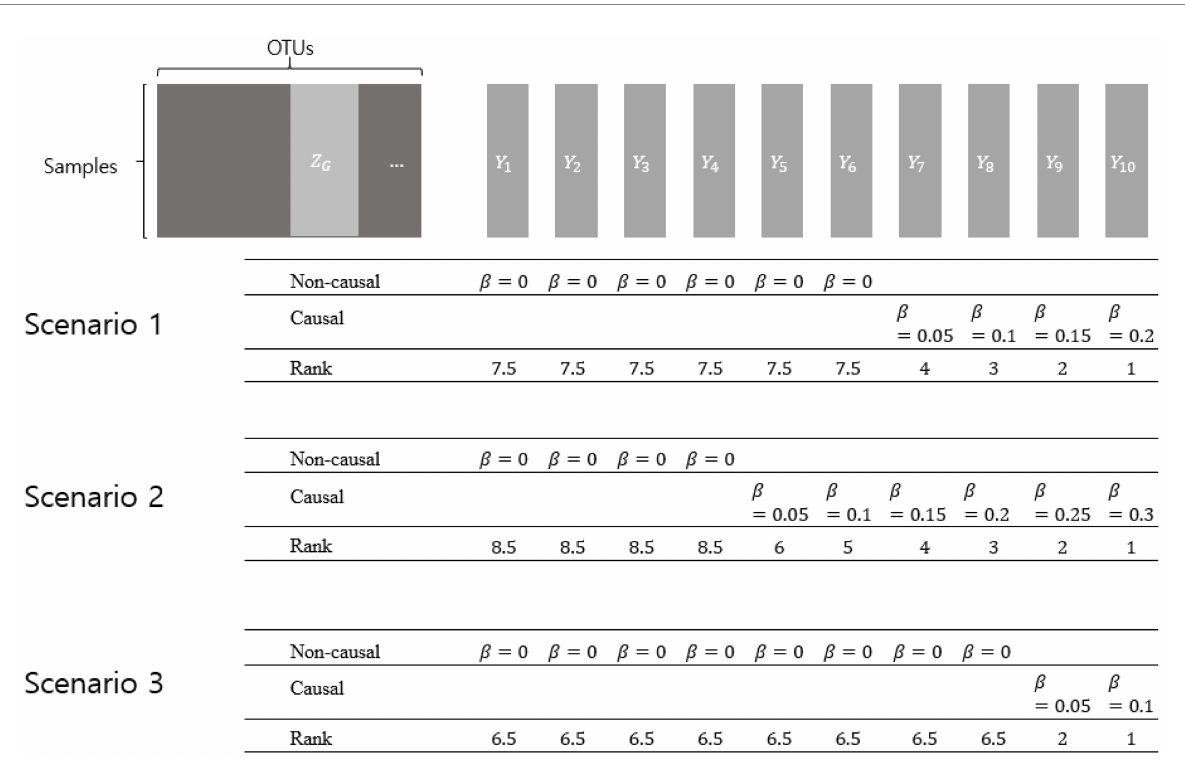
FIGURE 1 Simulation setting 2 with different scenarios. Z G represents a collection of OTUs comprising a genus. s Y represent dependent variables that were generated by various effect sizes ( β s). The larger effect size represents the higher rank. Non-causal β s have the value of zero, while causal β s have the value of more than